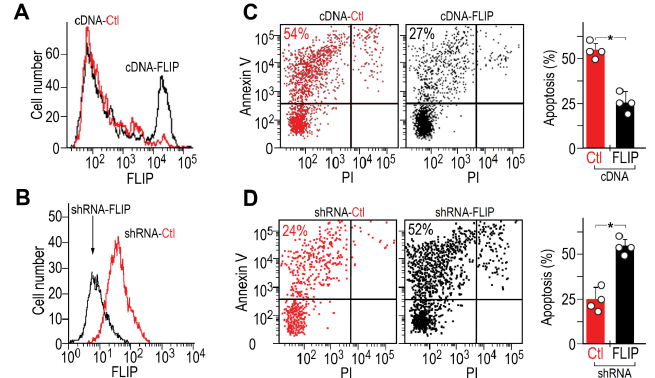
Figure 2. Critical role of FLIP in myofibroblast resistance to apoptosis and BLM-induced lung fibrosis. Flow cytometry of FLIP expression in myofibroblasts ( α SMA + ), isolated from ( A ) lungs resolving fibrosis (cDNA-Ctl, low FLIP), compared to those transfected with FLIP cDNA expression vector GFP + lentiviral vector (shRNA-FLIP). ( C,D ) Flow cytometry of Annexin V staining (left pair of panels) (cDNA-FLIP) and from ( B ), fibrotic-lungs (shRNA-Ctl, high FLIP), transduced with shRNA-FLIP-GFP + lentiviral vector (shRNA-FLIP). ( C , D ) Flow cytometry of Annexin V staining (left pair of panels) with graphical presentation (right panel), of the percentage of apoptotic transfected / transduced vs. control myofibroblasts, following Fas exposure. n = 4 * p <